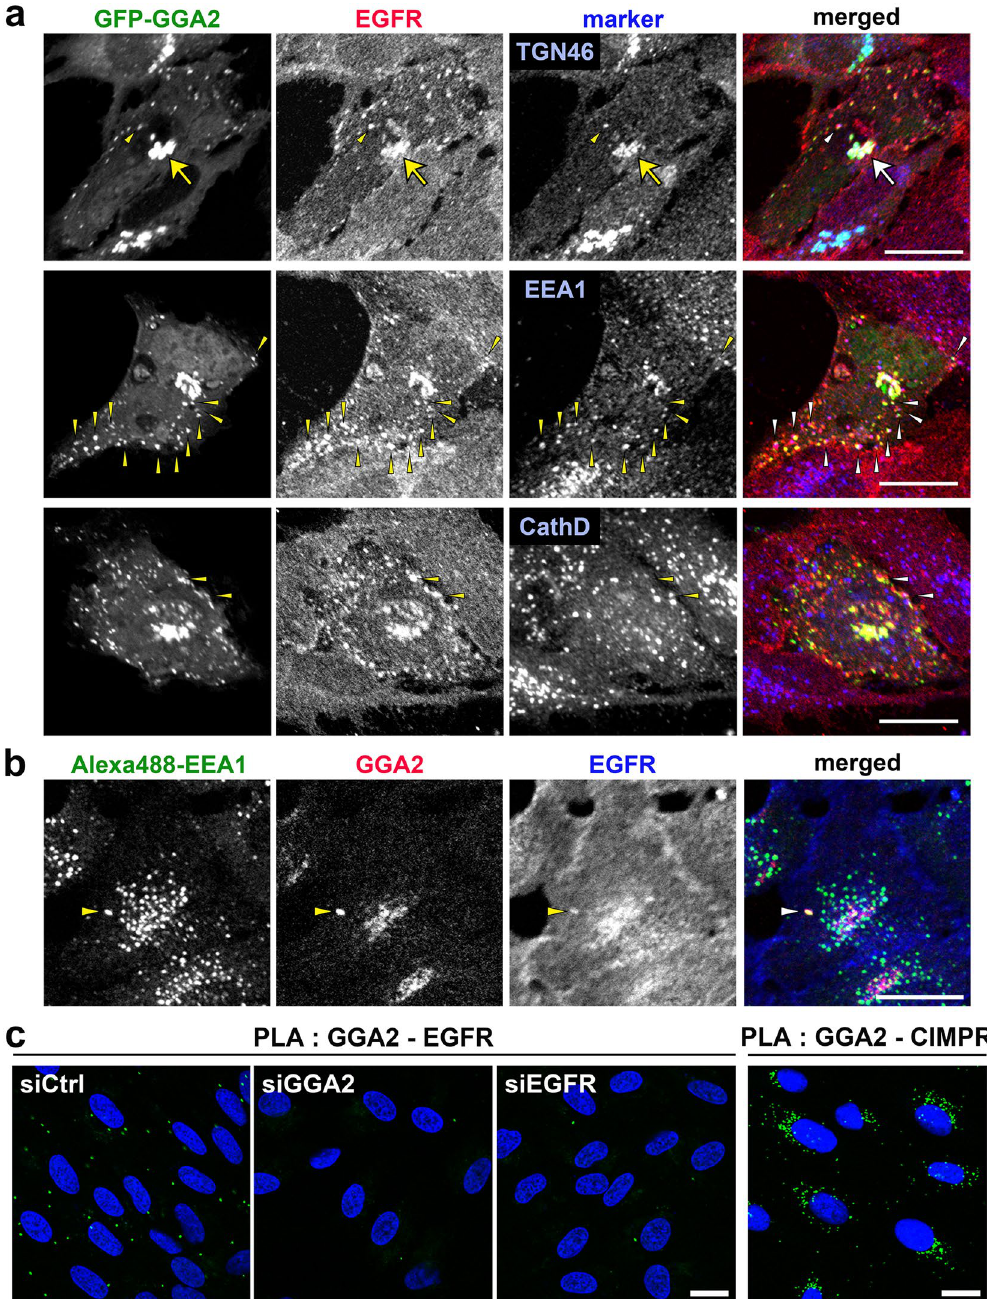
Figure 4. GGA2 colocalizes and interacts with EGFR in vivo . ( a ) ARPE-19 cells overexpressing GFP-tagged GGA2 were fixed and double immunofluorescence staining was performed using antibodies against EGFR (red) and TGN46, EEA1, or cathepsin D (blue). Arrows and arrowheads indicate colocalization of three signals in the TGN and peripheral structures, respectively. Bar, 20 μ m. ( b ) ARPE-19 cells were fixed for triple immunofluorescence analyses using antibodies against Alexa488-EEA1 (green), endogenous GGA2 (red) and EGFR (blue). Arrowheads indicate colocalization of three signals. Bar, 20 μ m. ( c ) ARPE-19 cells transfected with siCtrl, siGGA2, or siEGFR were processed for PLA to detect GGA2-EGFR or GGA2-CIMPR interaction (green). Nuclei were stained with DAPI (blue). Bars, 20 μ